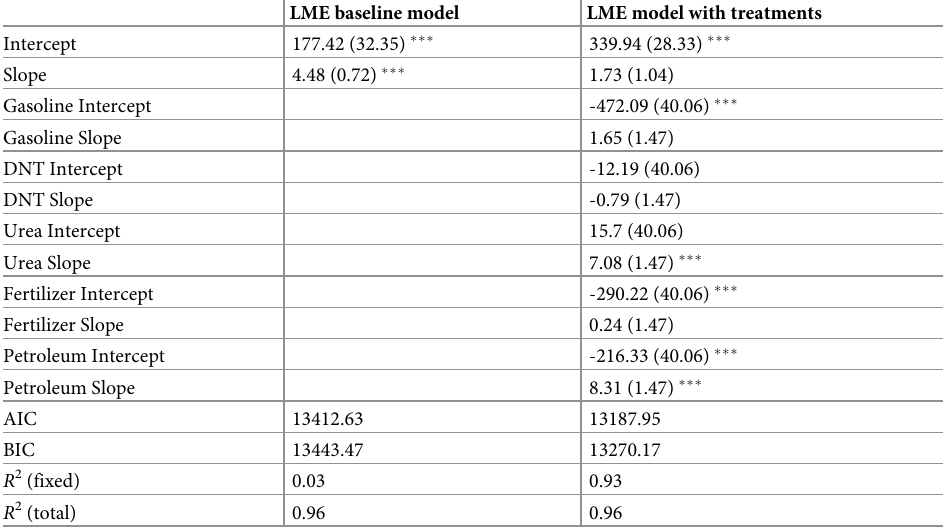
Table 1. Comparison of the baseline linear mixed effects (LME) model (without using treatments) and a LME model using the treatments as a